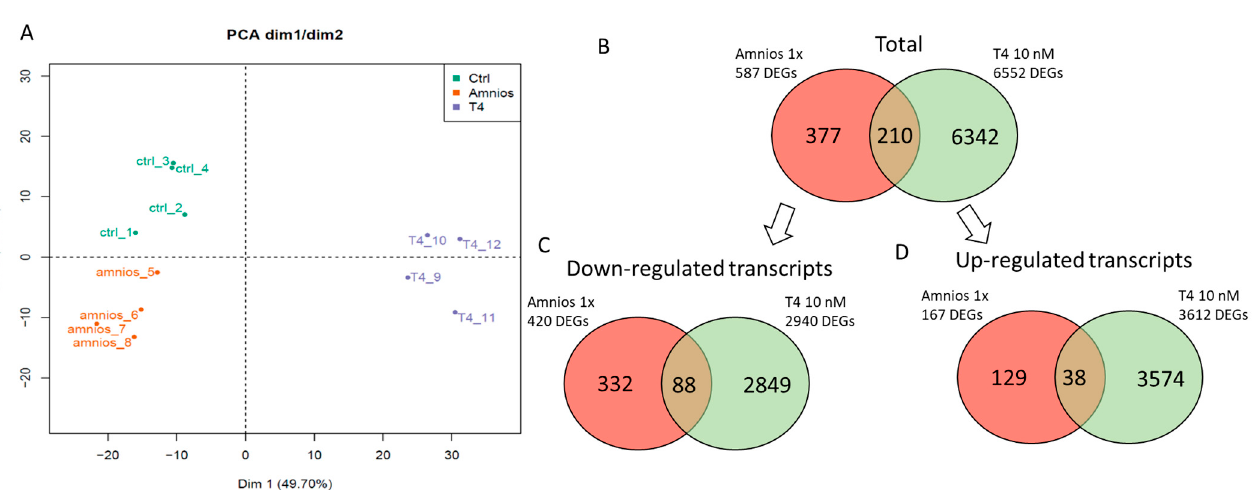
Figure 3. Principal component analysis plot of gene expression profiles from brain samples of exposed Xenopus tadpoles and Venn diagram from differentially expressed transcripts. ( A ) The profiles from the amniotic mixture (amnios ( n = 4)) cluster separately to clusters representative of T4 (T4 10 nM ( n = 4)) or control exposures (control ( n = 4)). ( B ) Venn diagram showing the differentially expressed genes in each group compared to the control. ( C ) Venn diagrams showing either down- or ( D ) up-regulated genes compared to the controls.